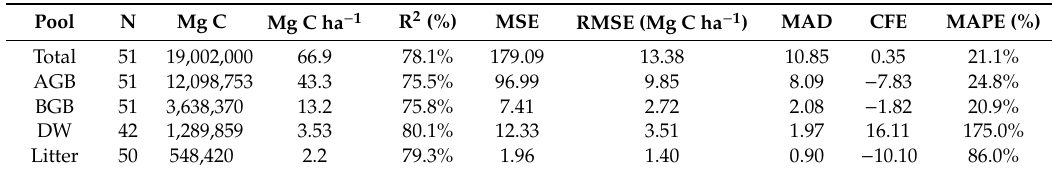
Table 6. Results of the accumulated carbon stock model, carbon stock for the different pools estimated, and their error measures based on random forest modeling.